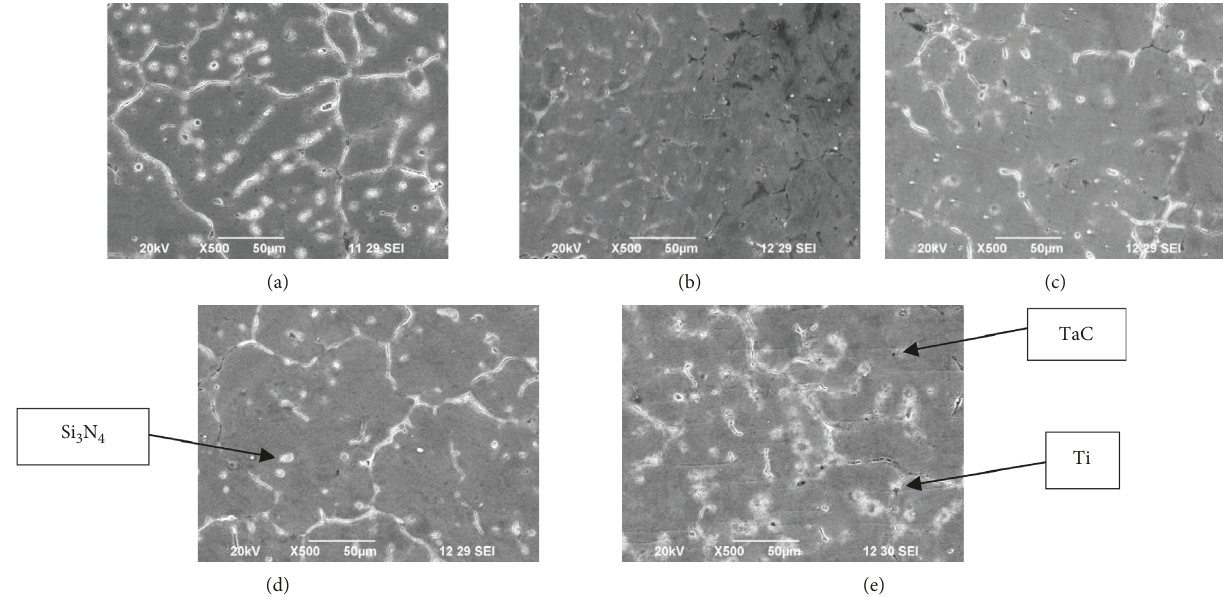
Figure 9: SEM morphology of the developed composites: (a) pure AA7075, (b) AA7075 +0.25wt%TaC+2wt%Si AA7075+ 0.5wt%TaC+4wt %Si3N4 +1.5wt%Ti, (d) AA7075+0.75wt%TaC+6wt% Si 3 N 4 + 1wt%Ti, and (e) AA7075+1wt%TaC+8wt% Si 3 N 4 +0.5wt%Ti.